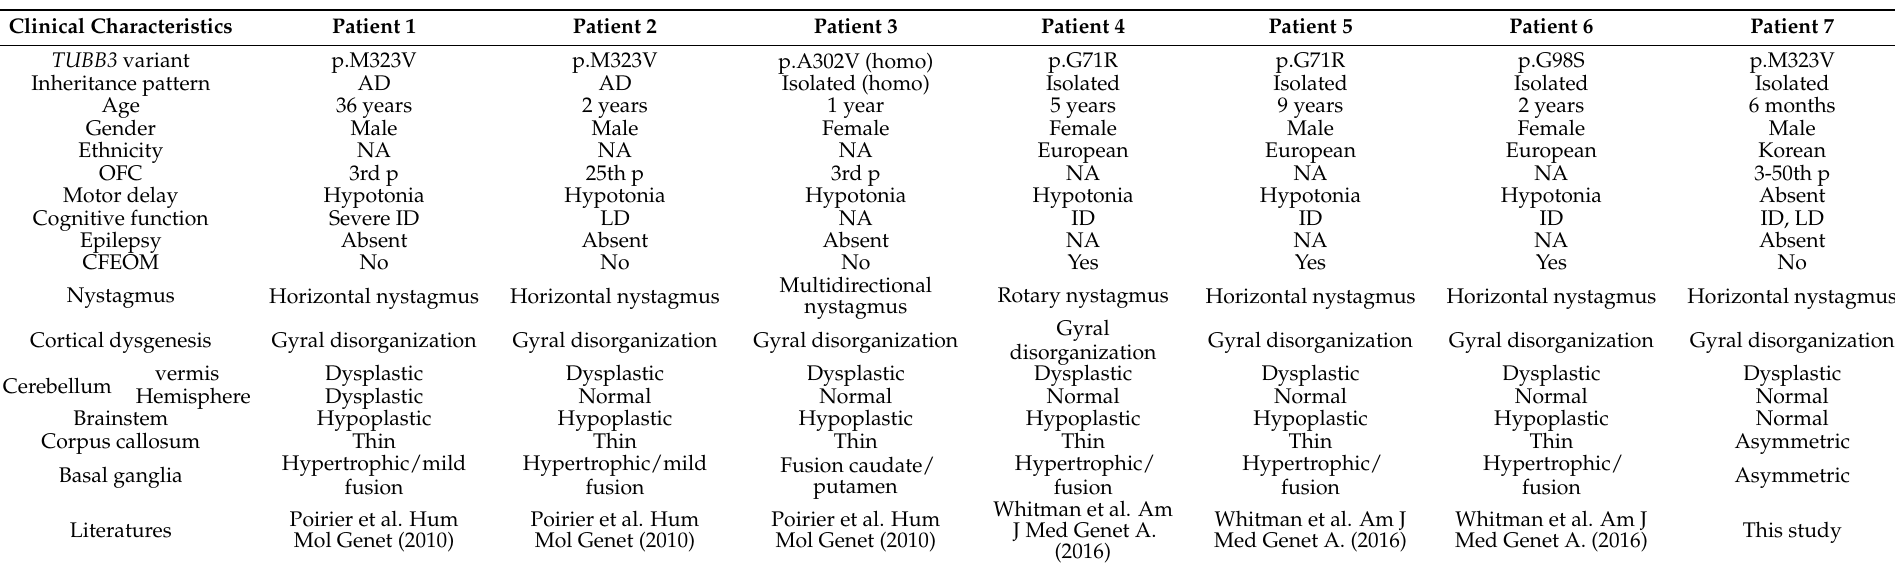
Table 1. Literature review of clinical characteristics in infantile nystagmus patients with the TUBB3